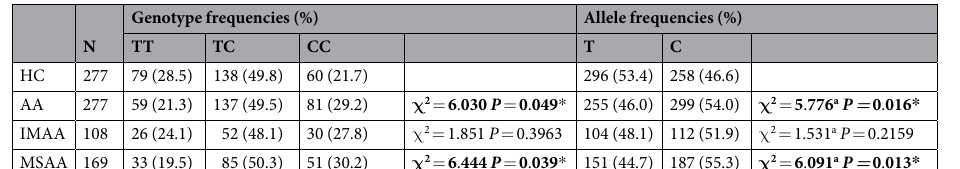
Table 3. Genotype and allele frequencies of the CD14 ( − 159 C/T) SNP in the study population. AA, allergic asthmatics; HC, healthy controls; IMAA, intermittent-mild allergic asthmatics; MSAA, moderate-severe allergic asthmatics. a Yates correction. * Significant